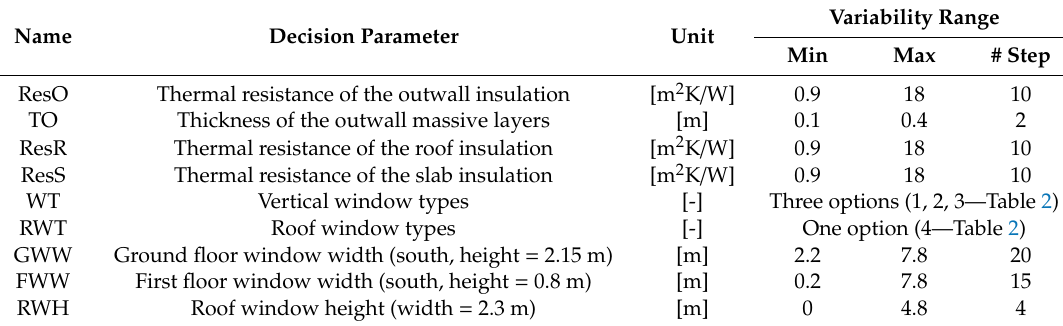
Table 1. Passive decision parameters (building envelope) and related variability range.